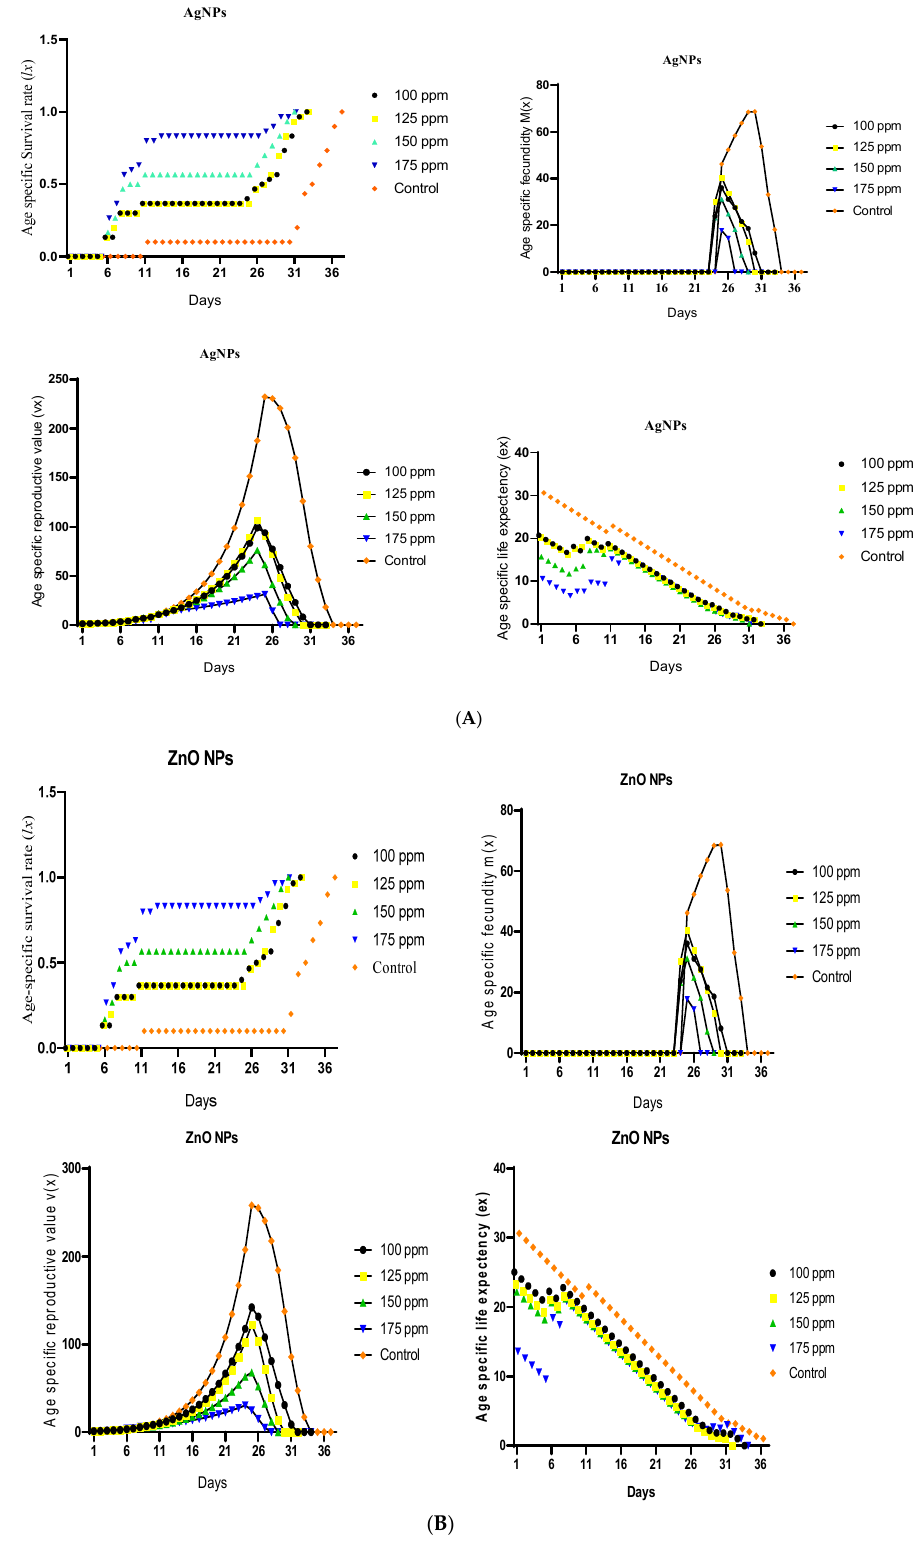
Figure 6. ( A ) Age-specific survival rate ( l x ), age-specific fecundity ( m x ), age-specific reproductive value ( V x ) and age-specific life expectancy ( e x ). ( B ) Age-specific survival rate ( l x ), age-specific fecundity ( m x ), age-specific reproductive value ( V x ) and age-specific life expectancy ( e x ).